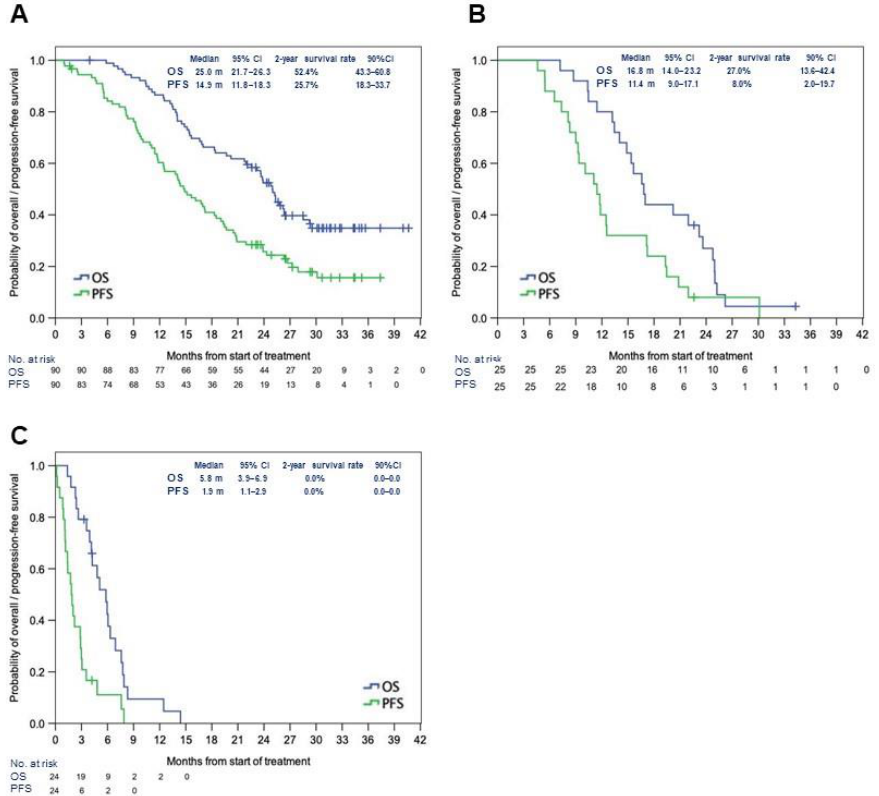
Figure 1. Median OS and PFS in the full analysis set ( A ), in the BBP group after initial treatment ( B